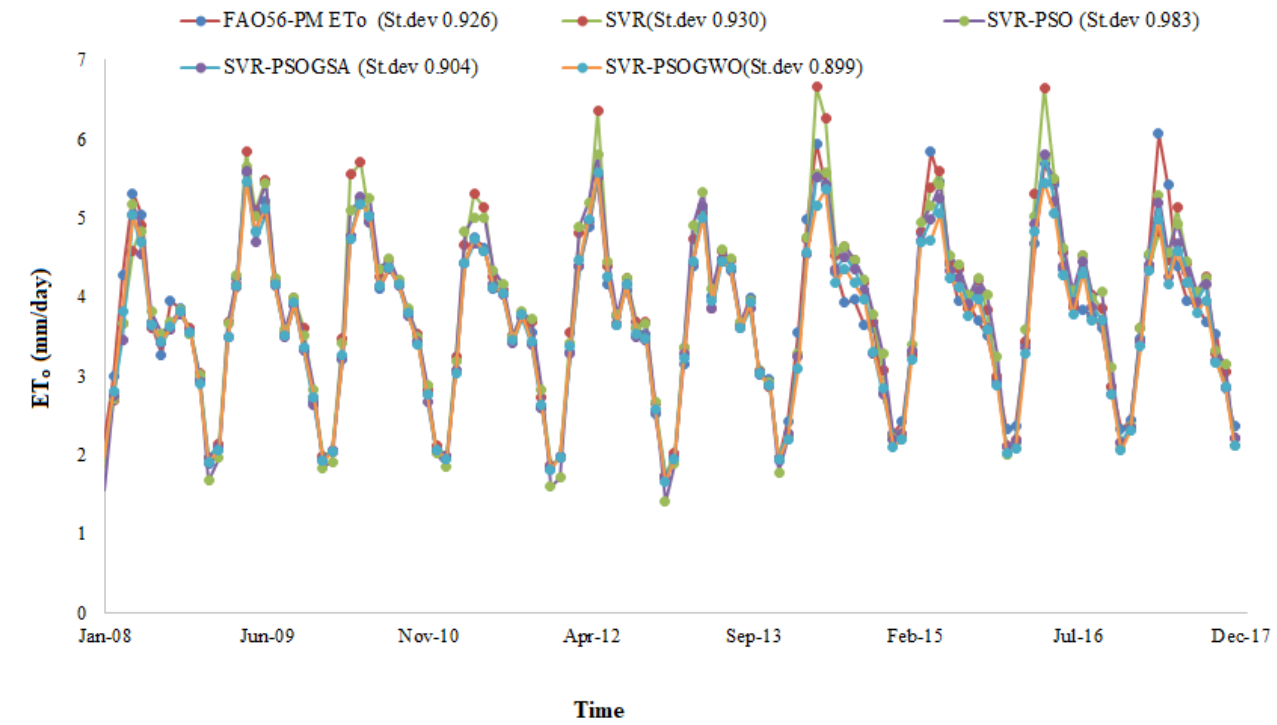
Figure 5. Time variation graphs of the FAO56-PM Eto and predicted ETo by different SVR-based models in the test period of Rangpur Station.